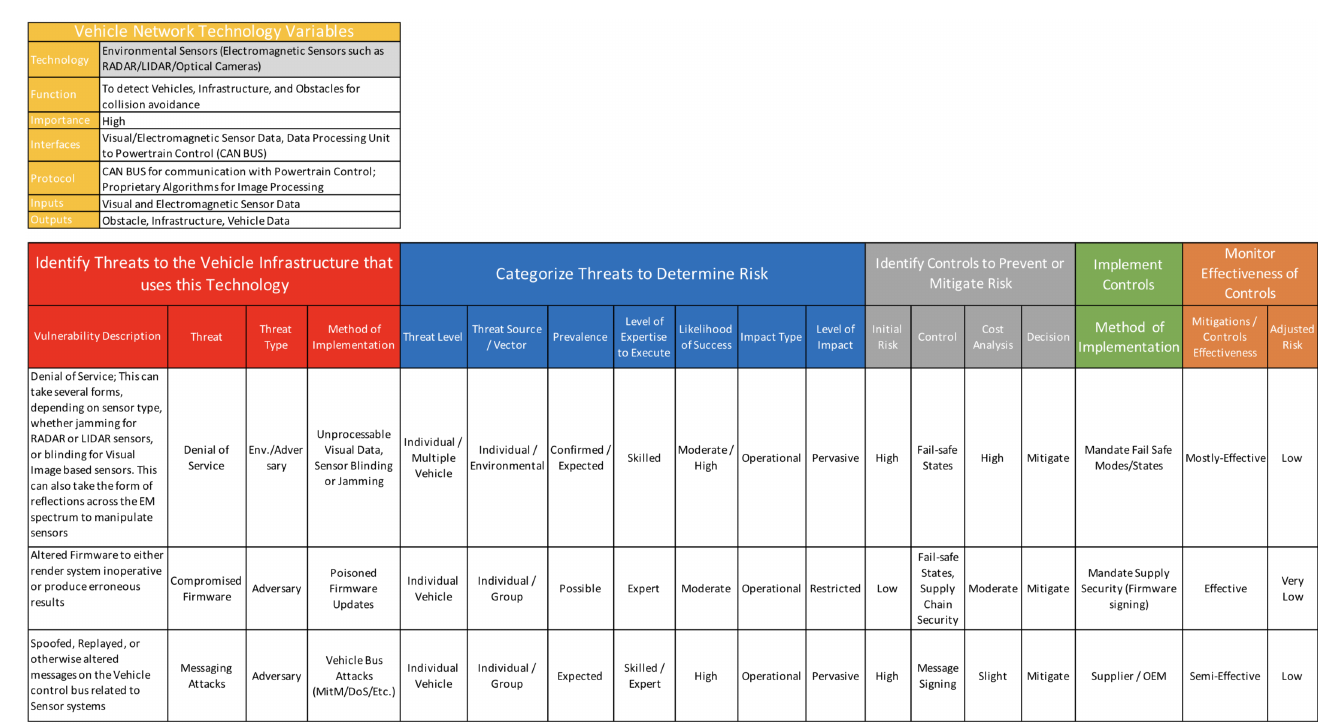
Figure A2. Vehicular Network Risk Management Process Example for Environmental Sensors (Electromagnetic Sensors such as RADAR/LIDAR/Optical Cameras).